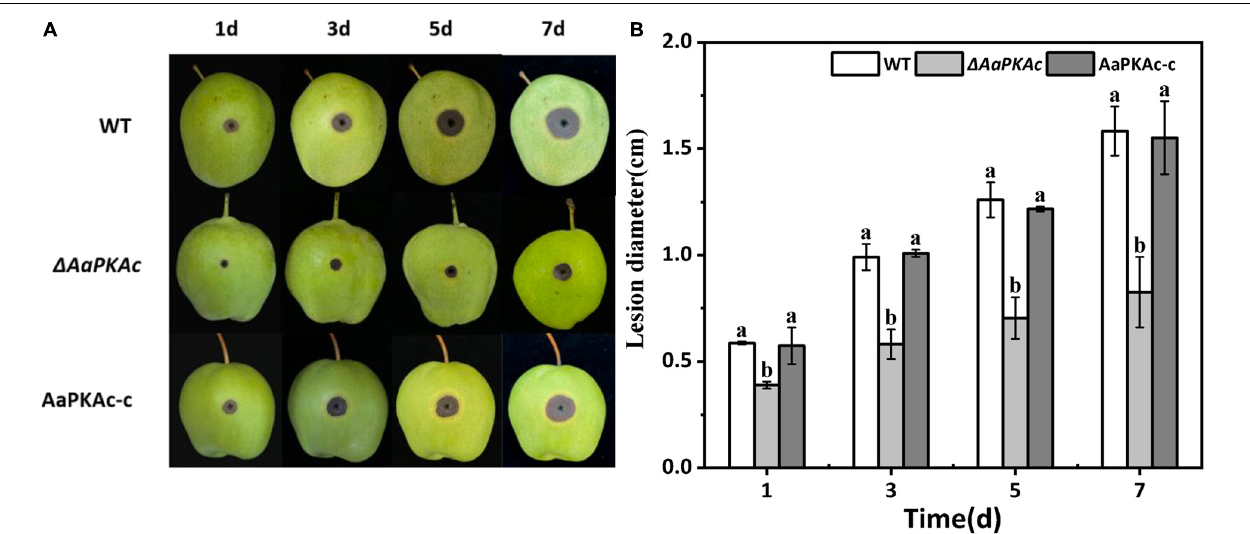
FIGURE 6 | Effect of AaPKAc on the pathogenicity of A. alternata. Fungal pathogenicity was assayed on pear fruits; each “Zaosu” pear fruit was wounded on the epidermis in the equatorial region with a sterile punch (2 mm deep, 5 mm wide); each wound site was inoculated with 20 µ L of conidial suspensions (10 6 spores mL − 1 ) prepared from the wild-type (WT), (cid:49) AaPKAc mutant, or AaPKAc genetic complementation strain (AaPKAc-c) (A) . Each strain required nine pear fruits; a total of 27 pears were counted. Statistical analysis of lesion diameter shown as histograms (B) . The vertical line indicates standard error ( ± SE). Different letters denote significant differences ( P <